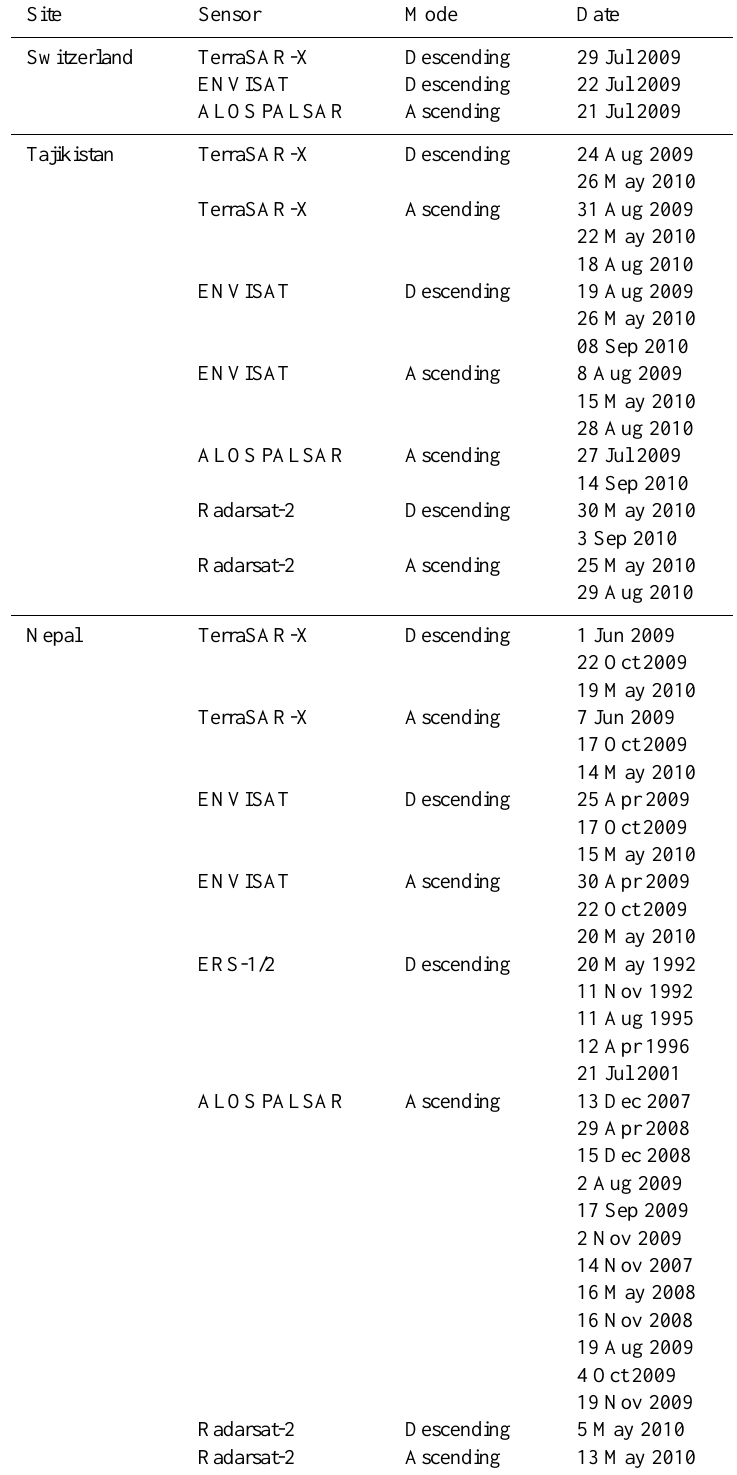
Table 1. Satellite SAR data considered in Switzerland, Tajikistan and